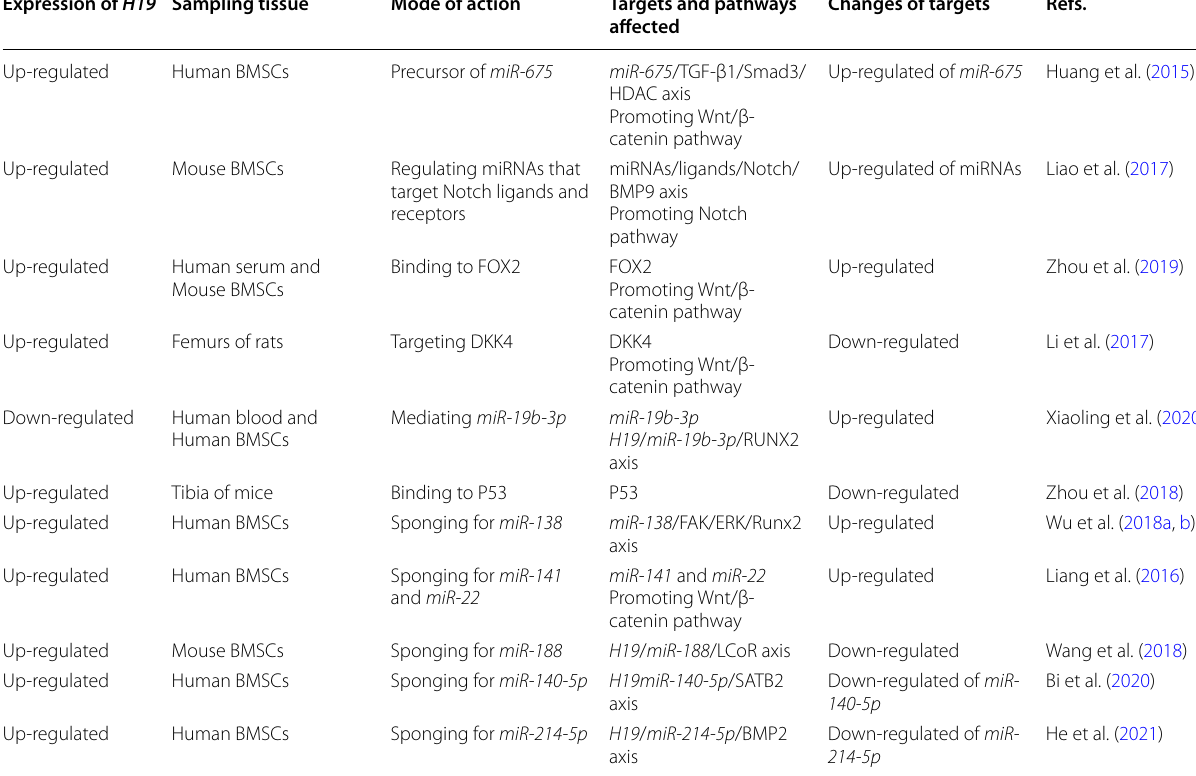
Table.1 Different roles of H19 in promoting osteogenic differentiation Expression of H19 Sampling